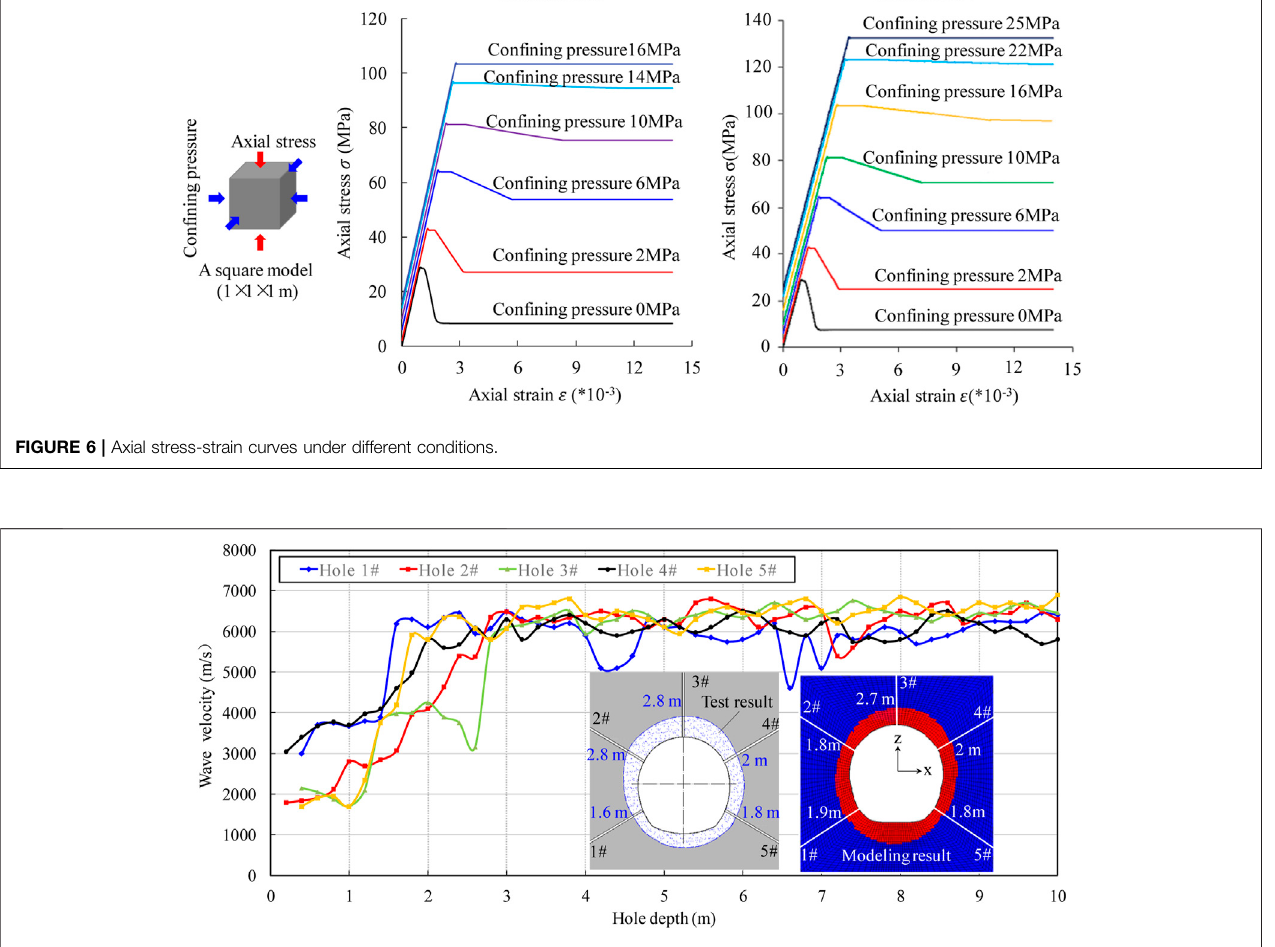
FIGURE 7 | Field test results of acoustic wave and excavation induced damage zone at K11+105 cross section.